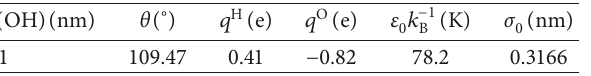
Figure 11: Molecular dynamics model without microstructure. Table 3: Parameter values of the SPC